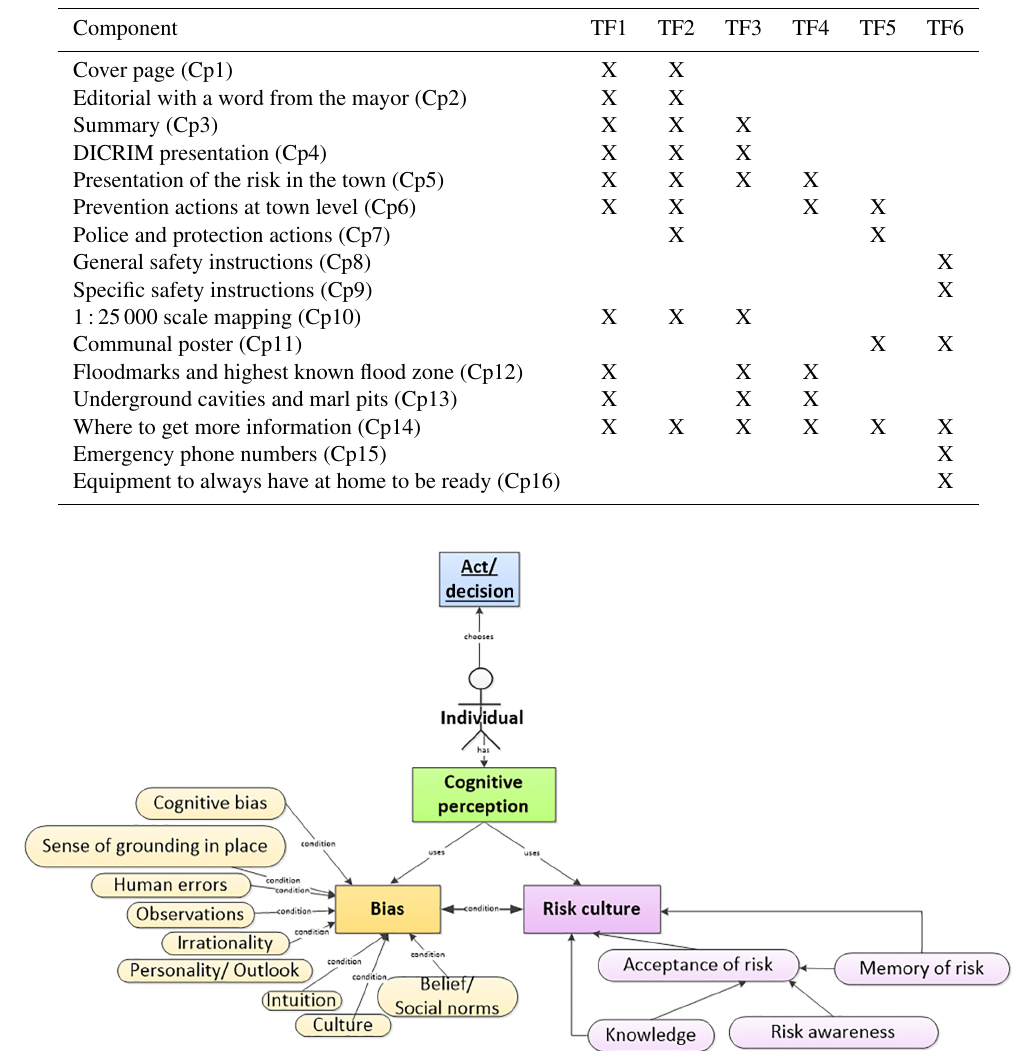
take refuge in the denial of that risk. Denial is part of a